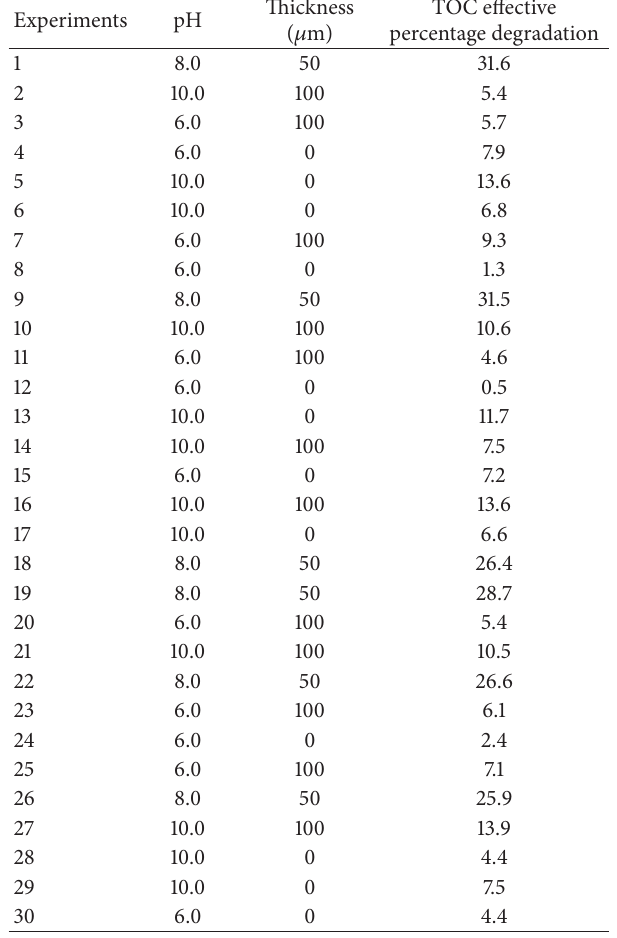
Table 3: Surface response methodology matrix using 2 factors and 15 runs in duplicate and TOC effective percentage degradation of the dairy effluent after the AOP